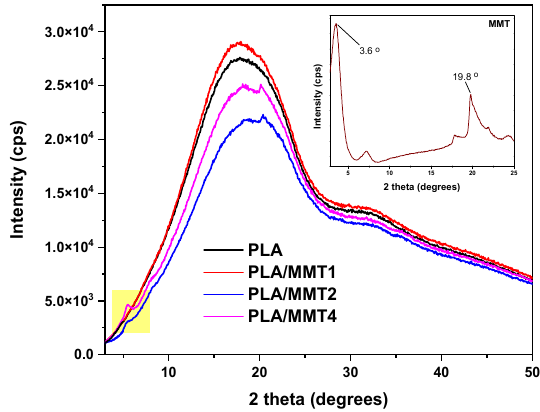
Figure 4. X-ray diffraction patterns of PLA, PLA/MMT and MMT.